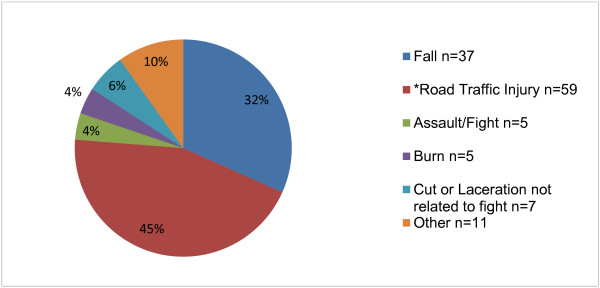
Types of injury.